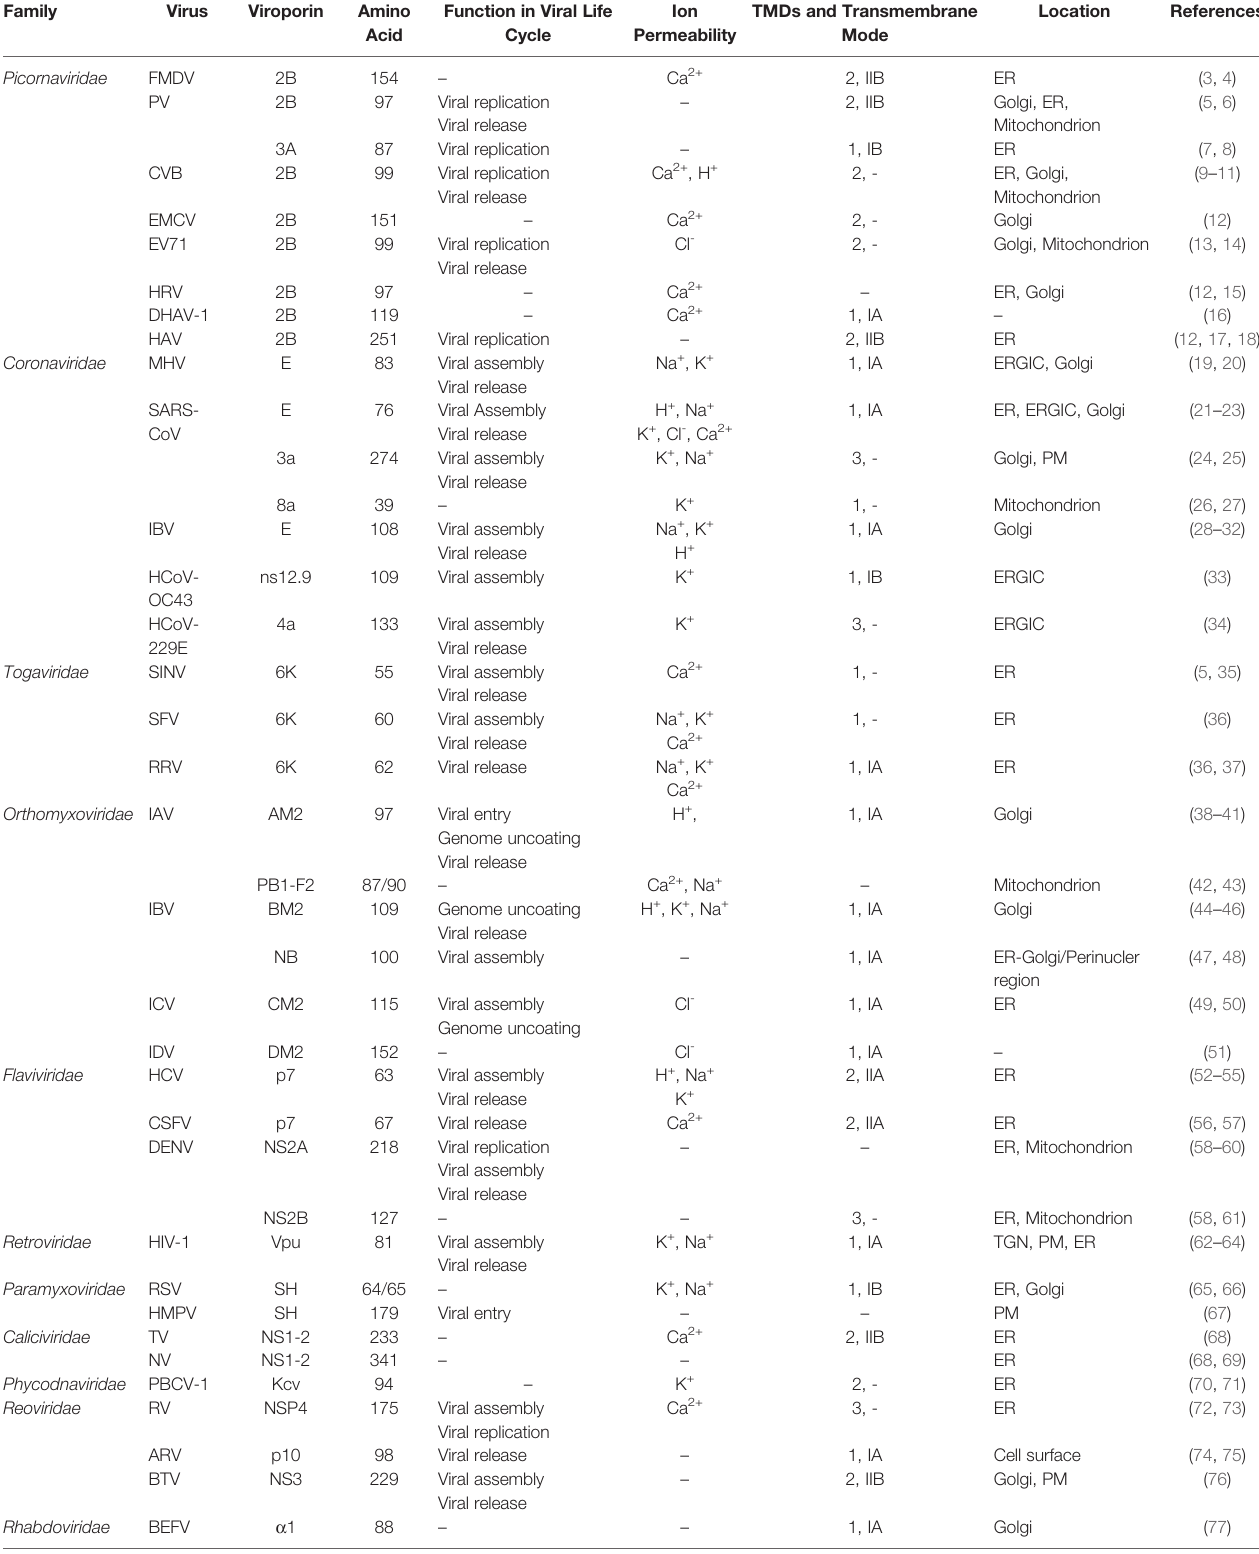
TABLE 1 | Viroporins and their roles in the viral life cycle.